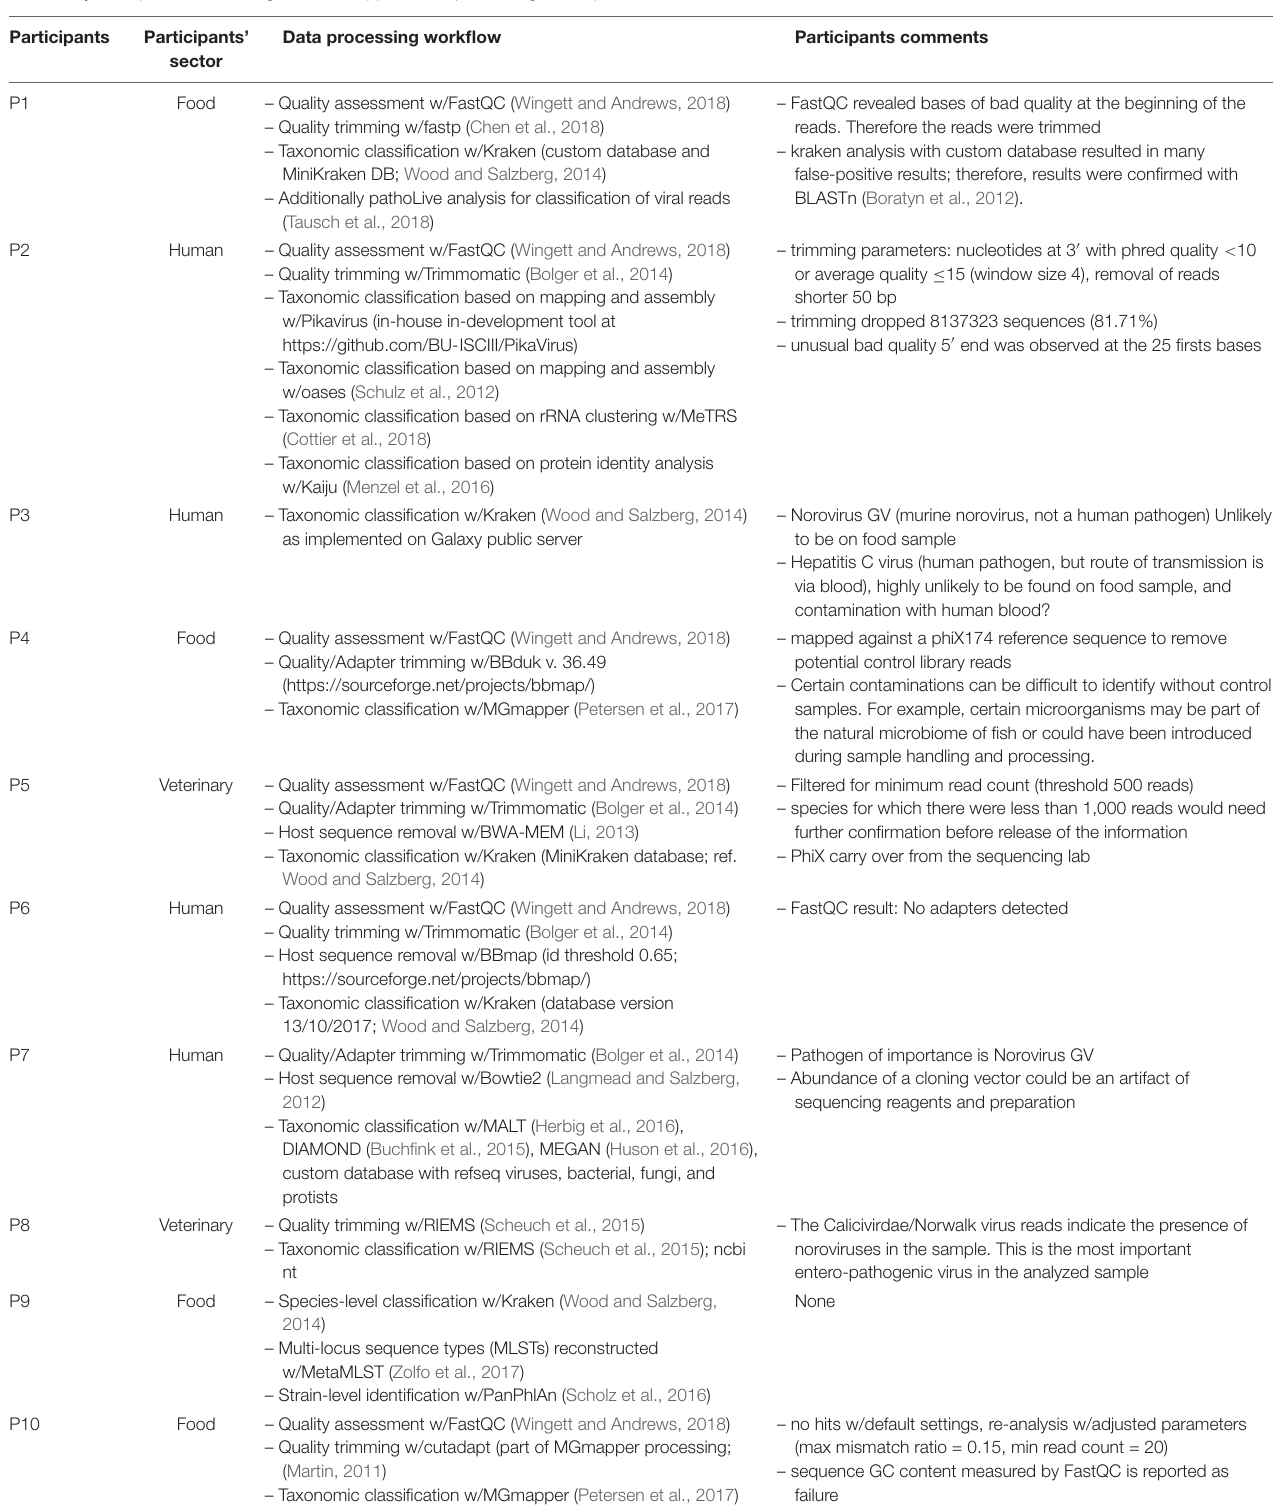
TABLE 2 | Participants, their background and applied data processing and important comments from their